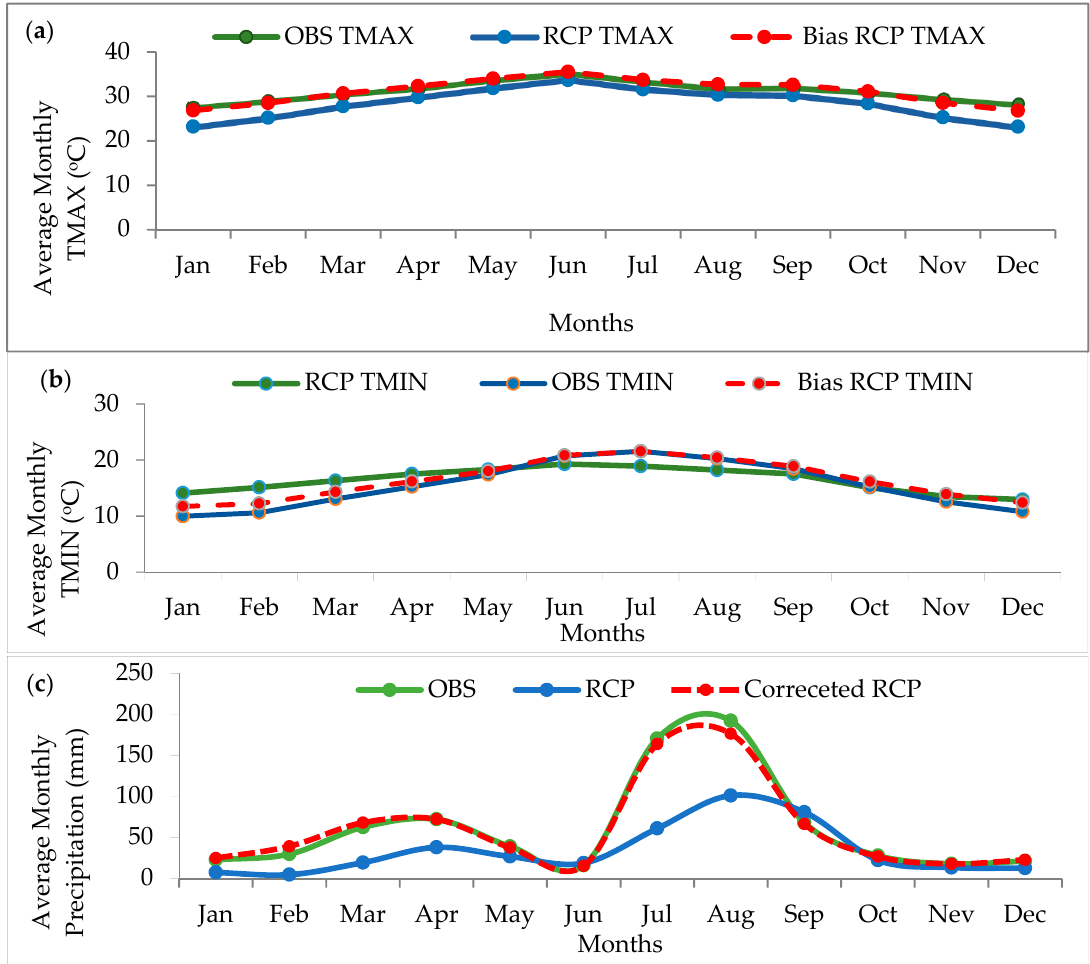
Figure 6. Observed and downscaled average monthly maximum temperature ( a ), minimum temperature ( b ), and precipitation ( c ) of observed vs. bias-corrected and un-corrected RCP time series (1988–2016) of the Logiya watershed.